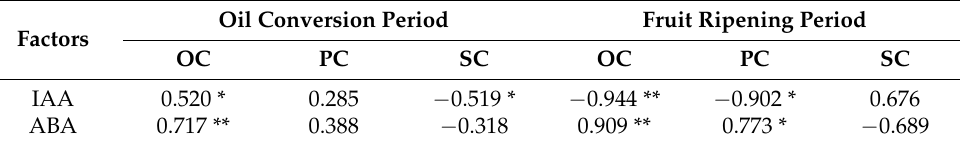
* PC, soluble protein content; SC, soluble sugar content; OC, oil content. All data shown indicate the mean of three biological replicates; * and ** represent significant correlations at the 0.05 and 0.01 levels,